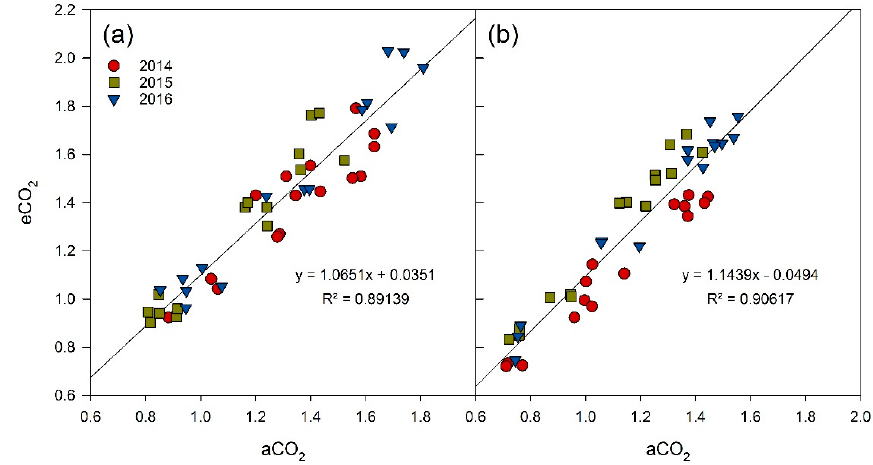
Figure 2. Relation between aCO 2 and eCO 2 values of single berry weight [g] between pre-veraison and harvest for Riesling ( a ) and Cabernet Sauvignon ( b ) of three independent sets of data collected in three different seasons 2014, 2015, and 2016.